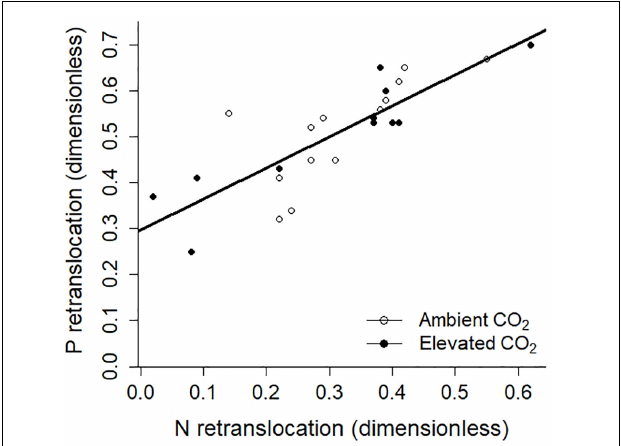
FIGURE 4 | Linear relationship between P retranslocation and N retranslocation across 5 years in ambient (open symbols) and elevated (closed symbols) CO 2 treatments, expressed as a fraction (dimensionless). The relationship was described as Y = 0.68 ∗ N retranslocation fraction + 0.30, R 2 = 0.66 and P <